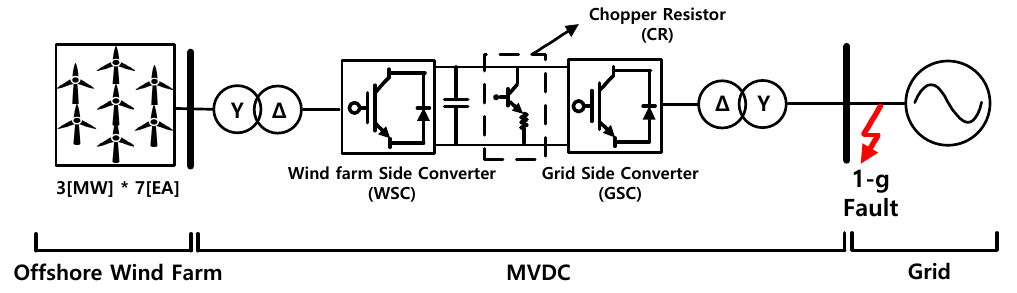
Figure 3. The configuration of the MVDC for the offshore wind farm.